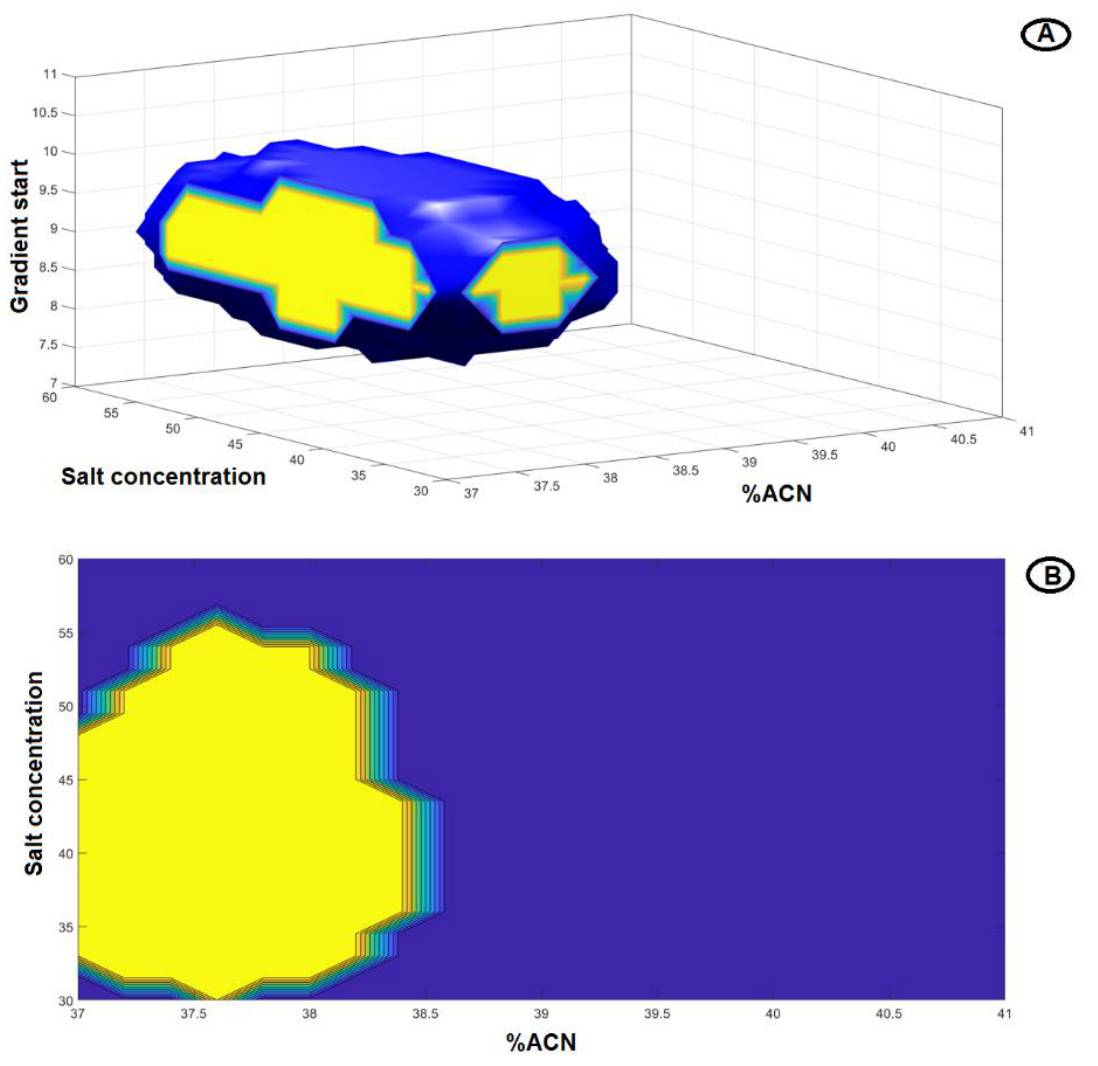
Figure 3. ( A ) 3D representation of DS for the predefined CMAs achieved with probability π ≥ 85%. ( B ) 2D representation of DS after setting a fixed value for C (gradient start time) = 10.0 min. The yellow part corresponds to the region of the design space where the working point should be situated.